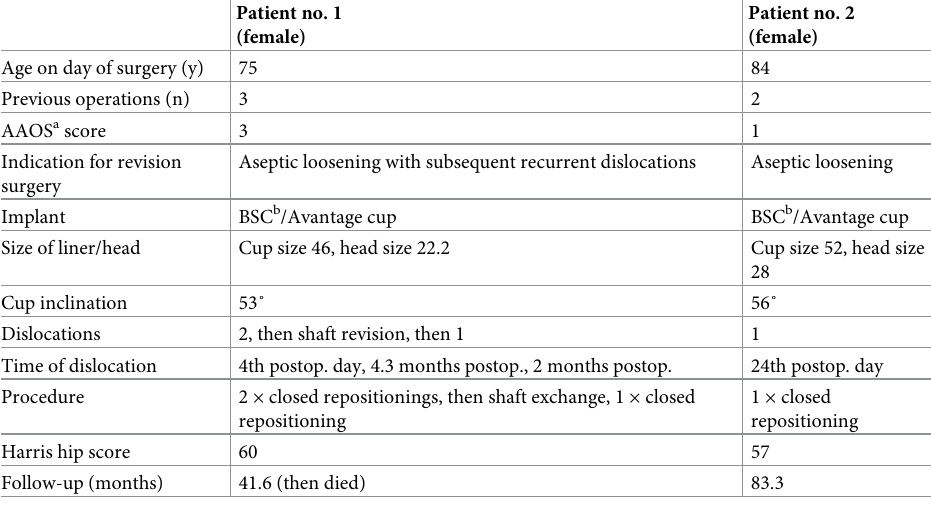
Table 3. Further details of the two patients in whom dislocations occurred.